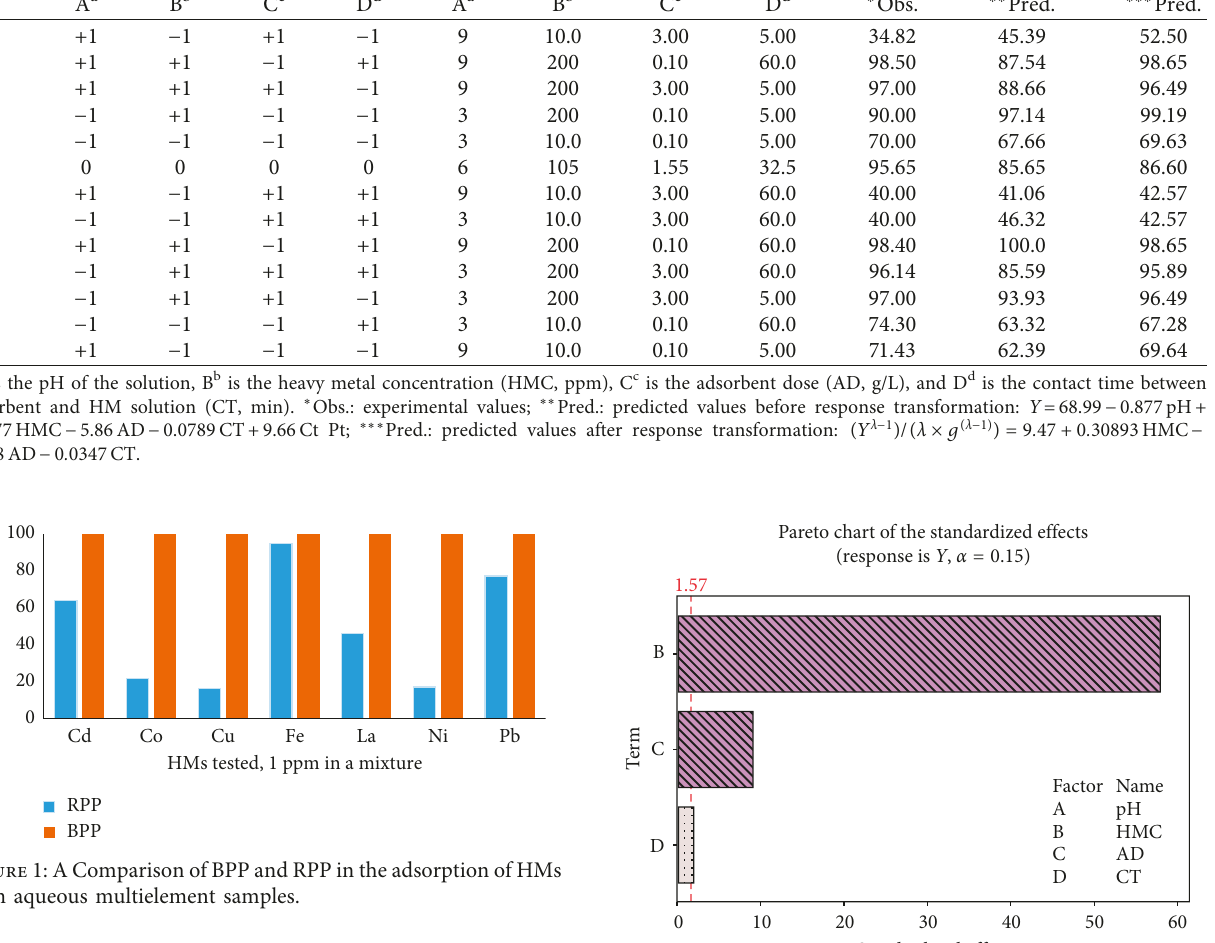
Table 3: PBD matrix for coded and uncoded variables. Response is shown as observed and predicted % of removal of Cd (II) using BPP. Coded levels of variables Run